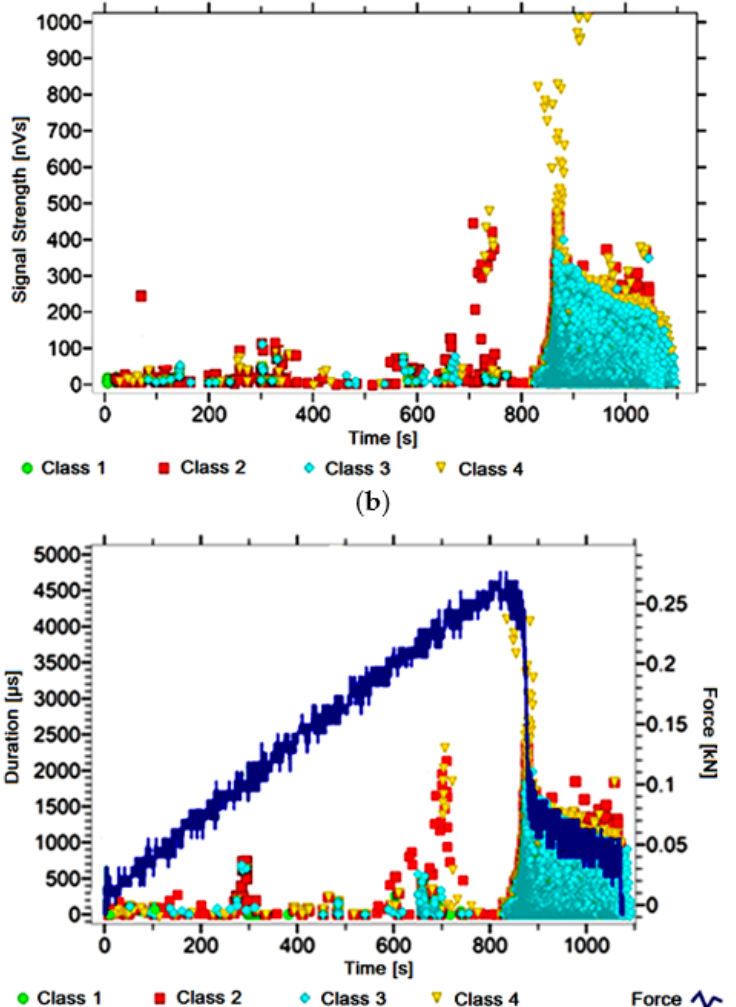
Figure 5. Graphs of acoustic emission signals for an exemplary sample of A 4 series: ( a ) signal strength over time; ( b ) distribution of the duration of the signals over time with the force increment curve.